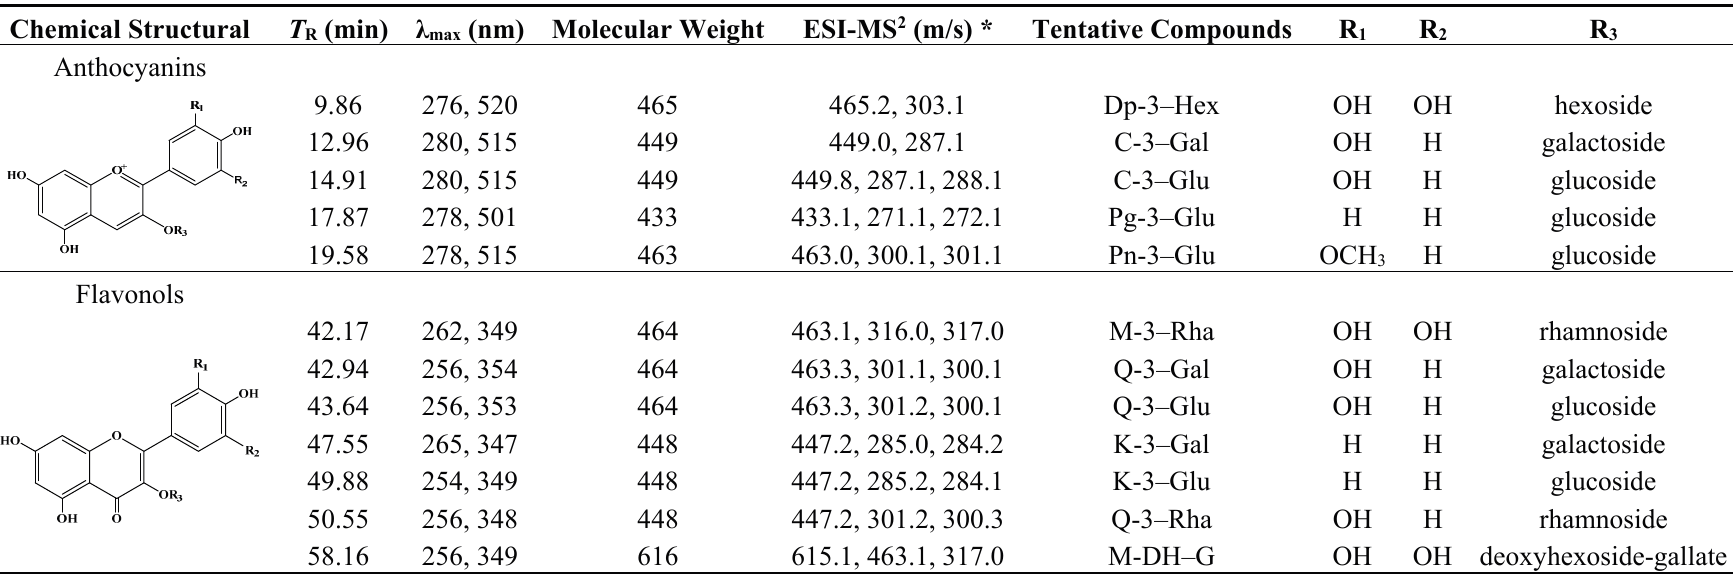
Table 3. Structural and chromatographic characteristics of investigated phenolic compounds. Dp, delphinidin; C, cyanidin; Pg, pelargonidin; Pn, peonidin; M, myricetin; Q, quercetin; K,